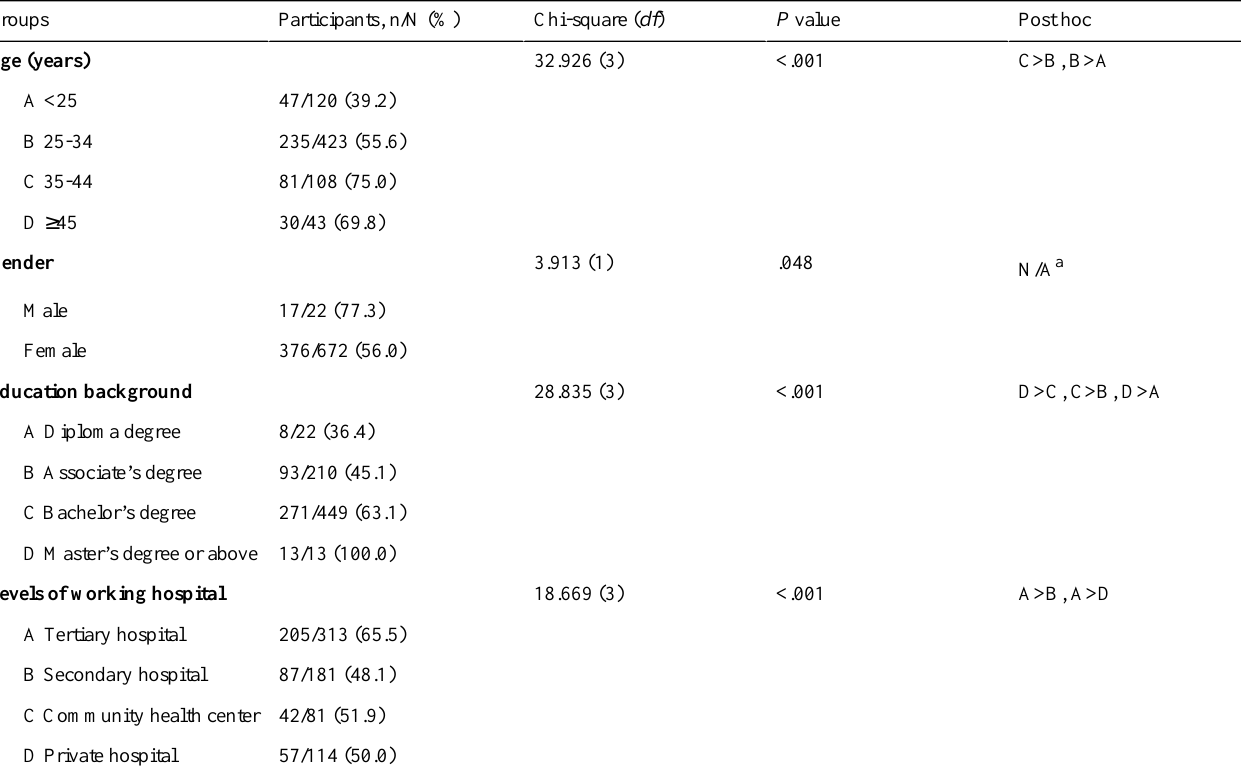
Table 4. Nurses who were aware of the sharing nurse